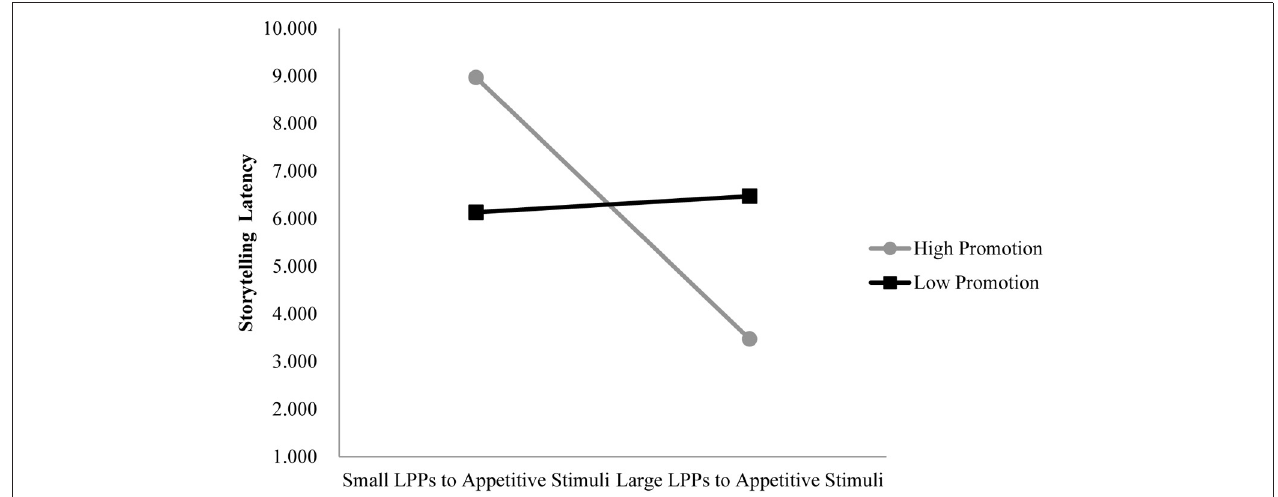
images in the central/late window. Model with LPP (central/late), Promotion Parenting, LPP × Promotion: (cid:2) R 2 = 0 . 108; unstandardized regression